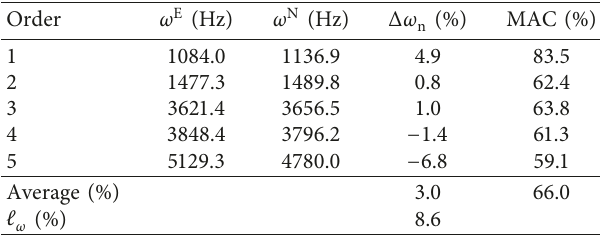
Figure 19: Comparison between the numerical (lines in black and blue) and experimental (lines in gray) FRF values for radial excitation ( y direction) and response measurement at point E1 ( z Table 6: Correlation between the natural frequencies and modal numerical and experimental shapes for the stator model without the physical presence of the winding.